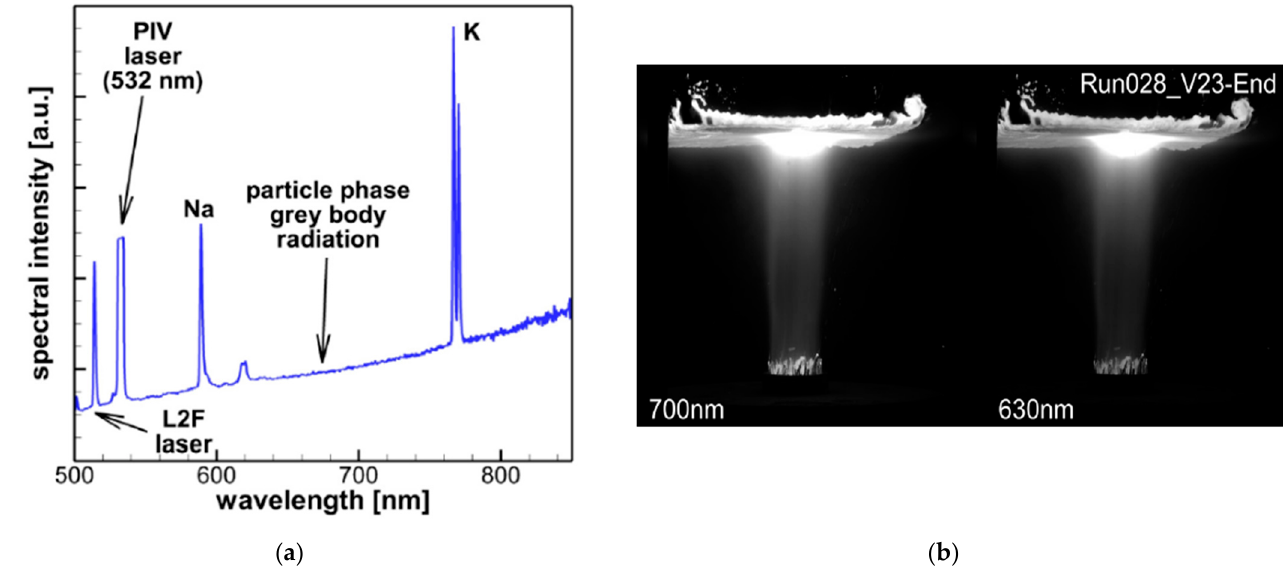
Figure 7. ( a ) UV–VIS spectral intensity of the exhausted gases (5% aluminum, Run012-V29-End). ( b ) Images of the case with 18% of aluminum at 630 and 700 nm (Run028-23-End). Reprinted with permission from Ref. [28] (2021).